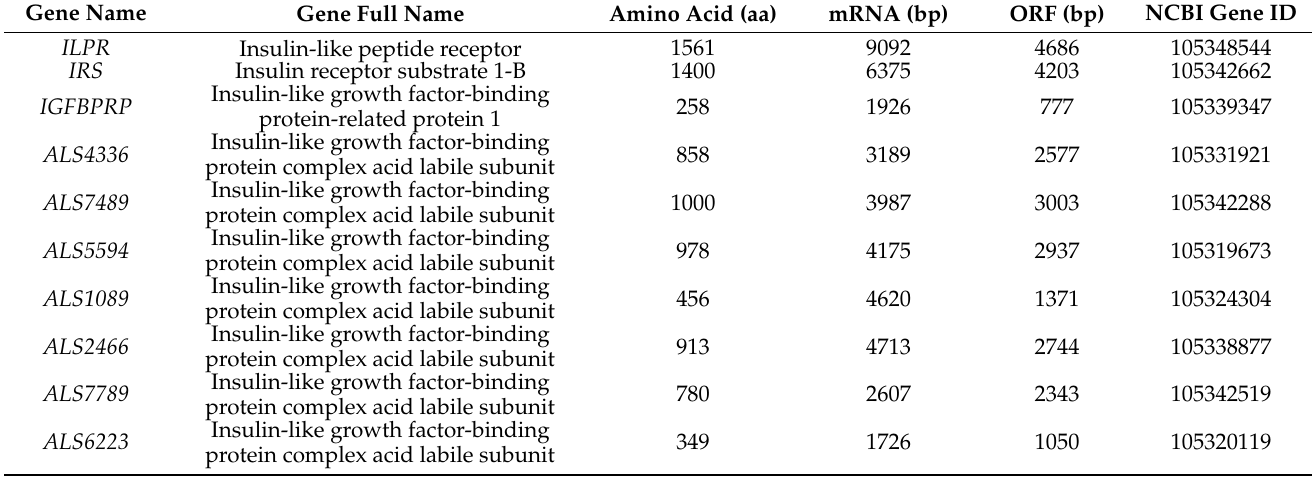
Table 1. Sequence characteristics of the IIS signaling pathway genes in Crassostrea gigas.